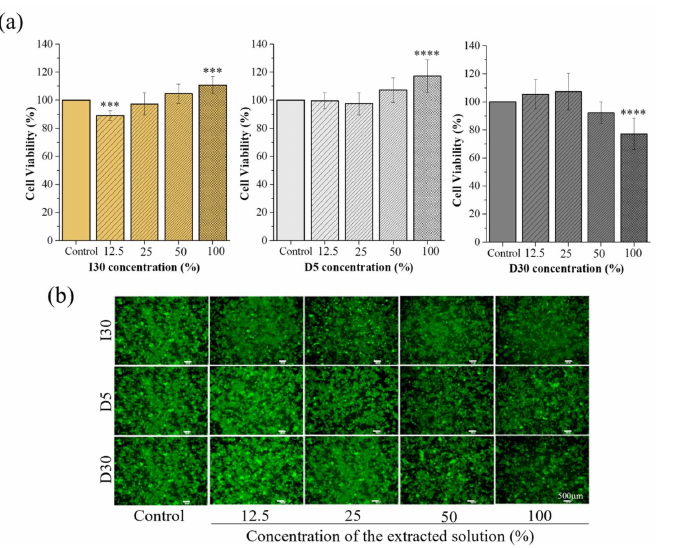
Figure 3. Cytotoxicity of the extract of NaI-incorporated paste (NaI@P). ( a ) Cell viability results from the CCK-8 assay. ( b ) Live/Dead staining results. The statistical significance of ( a ) was calculated using a one-way analysis of variance (ANOVA) followed by a two-sided Dunnett’s multiple comparison test compared to the control. *** p < 0.001, **** p < 0.0001, n =